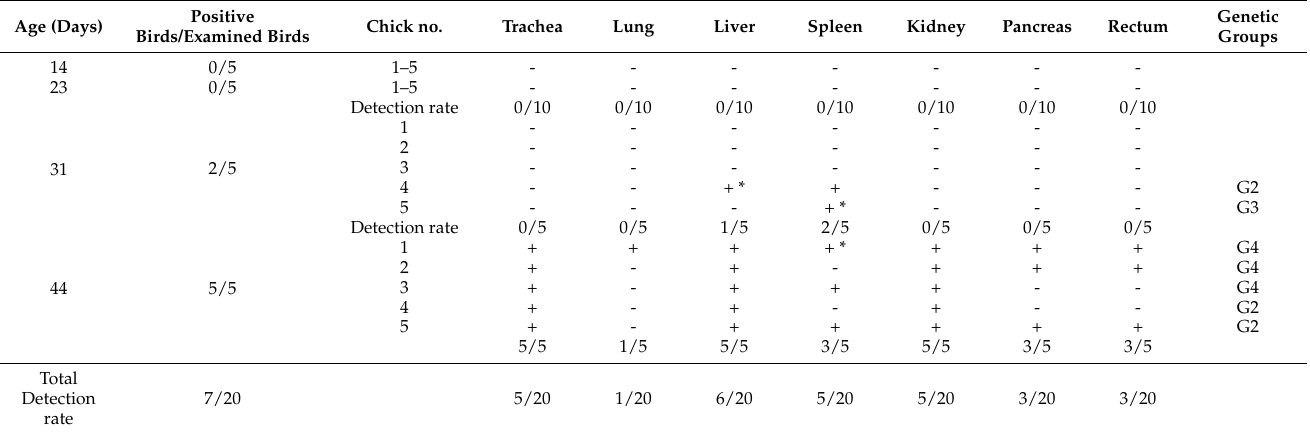
Table 2. Detection of GyVg1 in various organs in chicken from farm